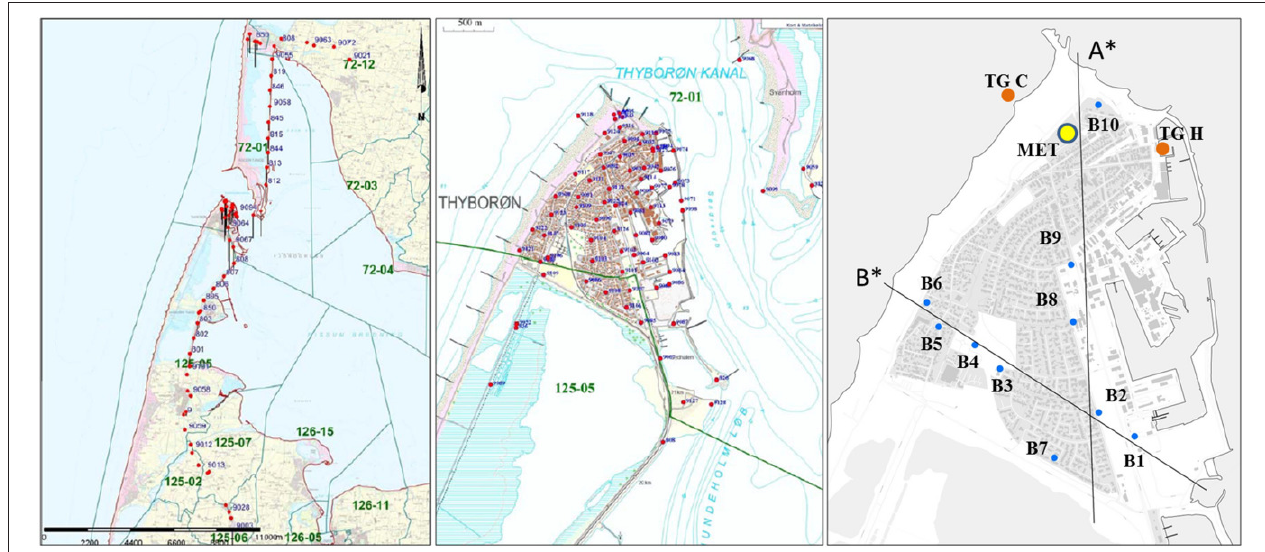
FIGURE 3 | Benchmarks along the Limfjord barrier (left) between Vestervig Church (NE) and Hove Church (S) and a zoom-in on Thyboron (middle). Groundwater monitoring (B1–B10), tide gauge (TG C & TG H) and meteorological (MET) station positions are plotted (right) together with lines (A * , B * ) along which groundwater stations are approximately